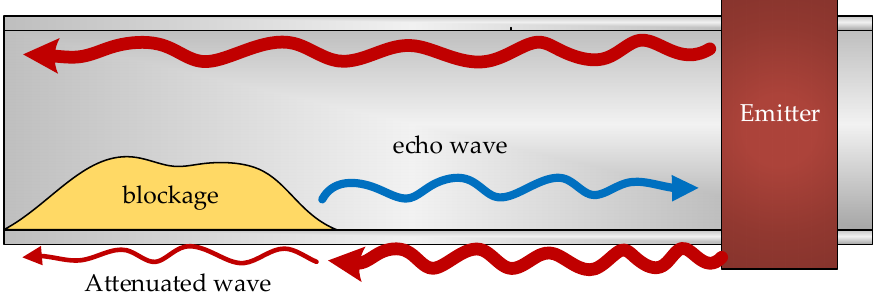
Figure 6. Blockage detection. Once the ultrasonic wave reaches the blockage, it produces an echo that can be used to determine its position, but the wave continues, with certain attenuation, in the same direction. The attenuation introduced by the blockage depends on the material.